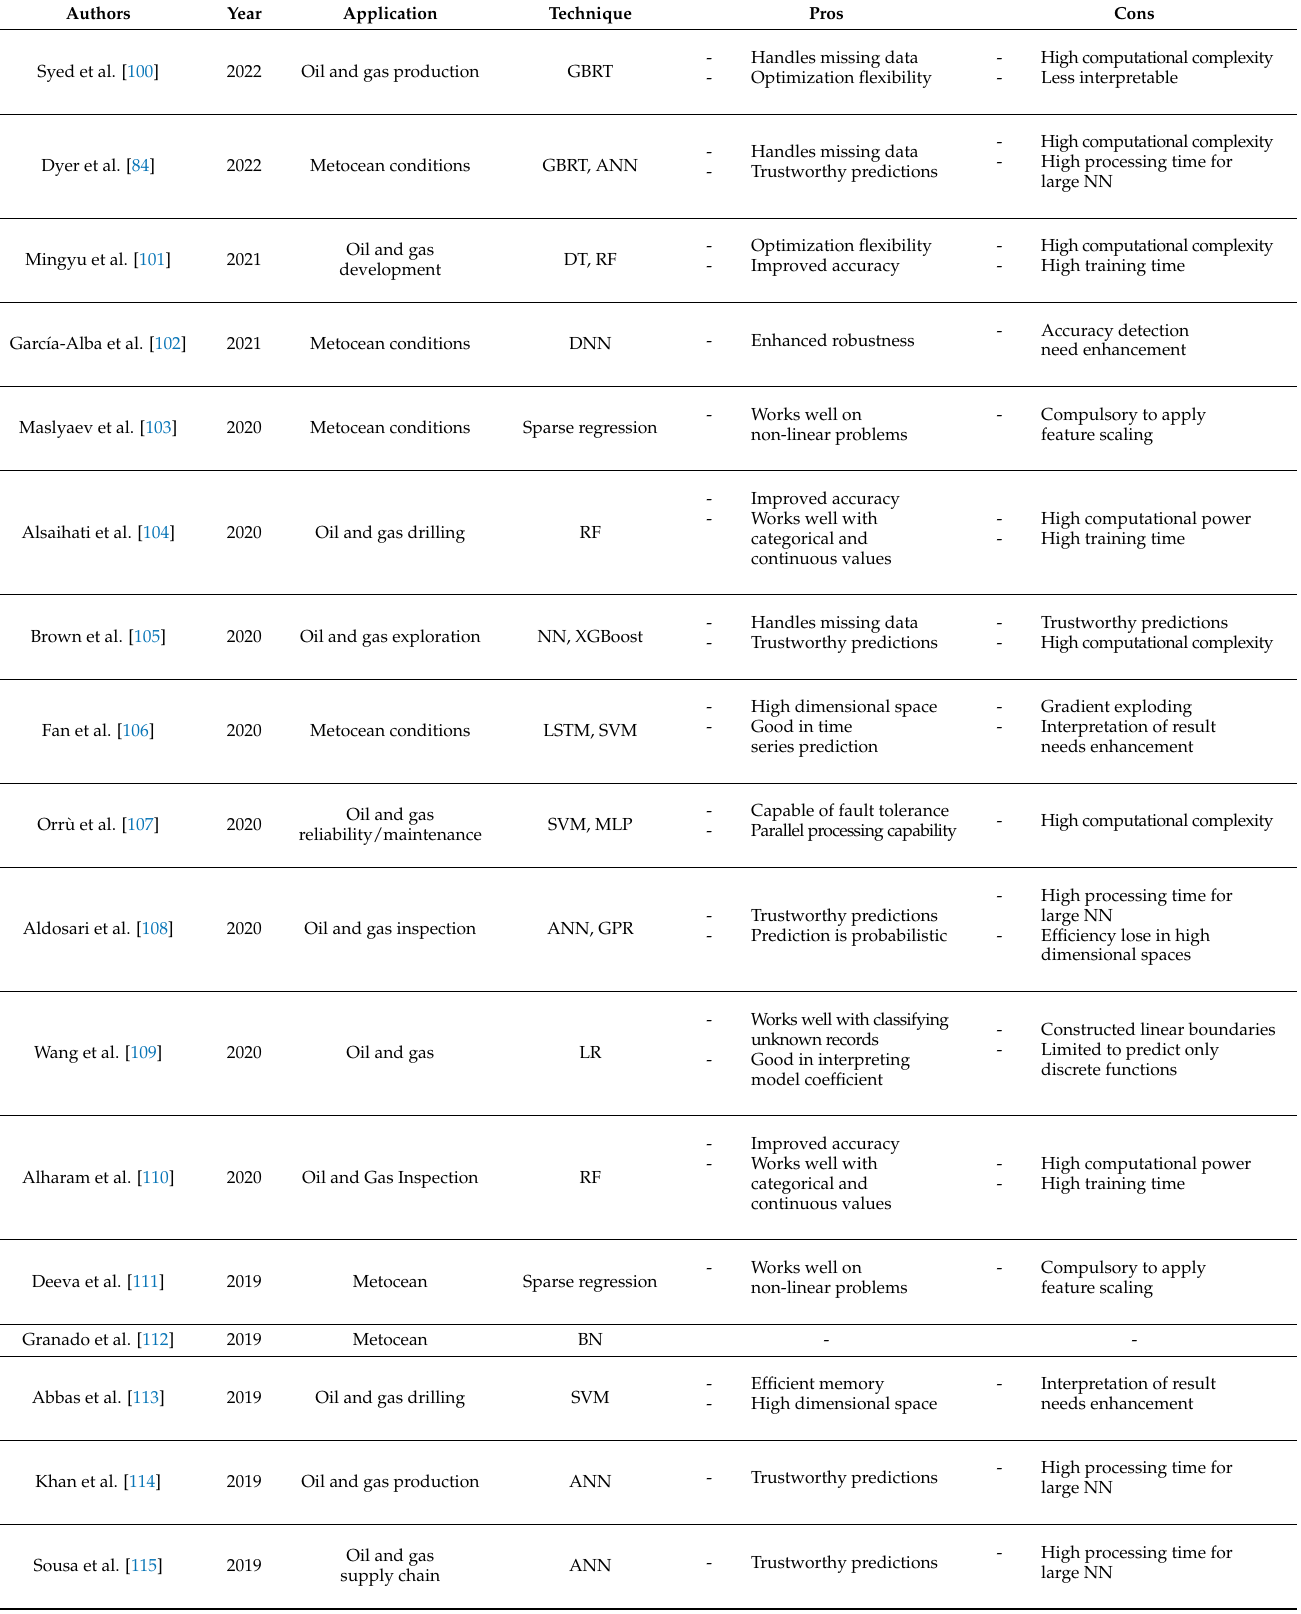
Table 3. List of ML state-of-art studies with their pros and